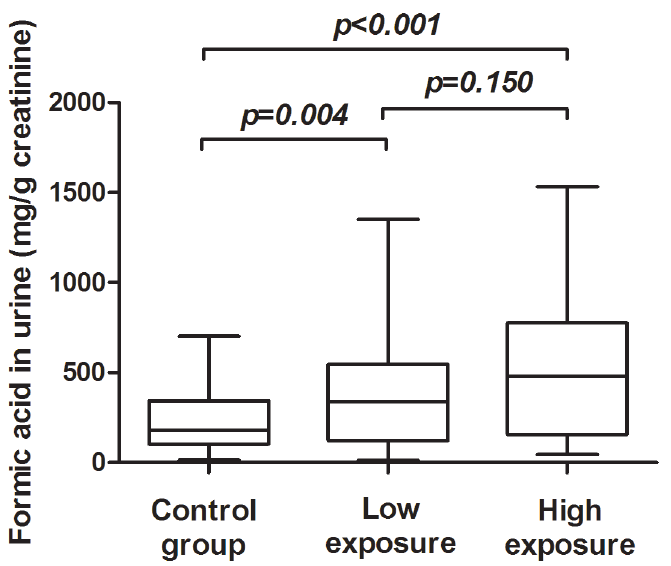
Figure 1. The level of formic acid in FA-exposed workers (n=48 in the low exposure group and n=70 in the high exposure group) and the control (n=79). Sample was detected for the level of formic acid by high performance liquid chromatograph (HPLC). The final formic acid concentration was adjusted by urine creatinine. doi:10.1371/journal.pone.0104069.g001 PLOS ONE |